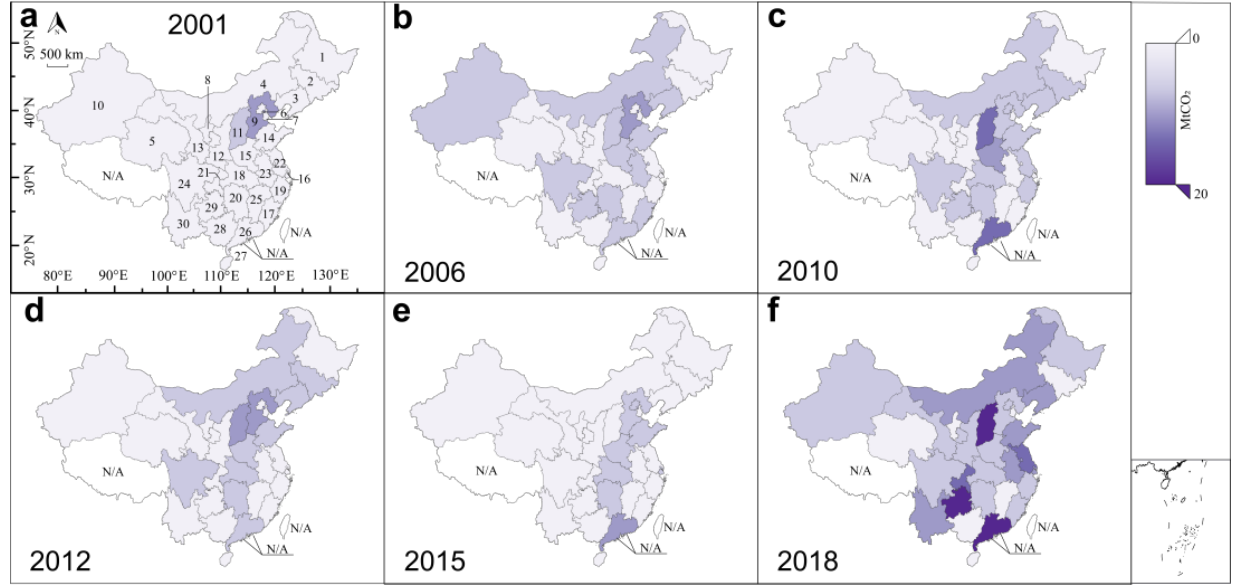
Figure 3. Changes in carbon mitigation of residential buildings by province. Note: the numbers indicate the names of the provinces which can be found in Appendix A. Based on the review of carbon mitigation strategies for residential buildings in China, various observation years were selected from 2001 to 2018, as detailed in Appendix B. ( a ) The carbon mitigation of residential buildings in 2001, ( b ) 2006, ( c ) 2010, ( d ) 2012, ( e ) 2015, ( f ) 2018. To deeply explore the future carbon mitigation potential, carbon mitigation efficiency was included in the evaluation framework, expressed as the proportion of carbon miti- gations in the total carbon emissions from residential buildings for the whole province (see Equation (16)). The overall carbon mitigations and corresponding carbon mitigation efficiency of each province is shown in Figure